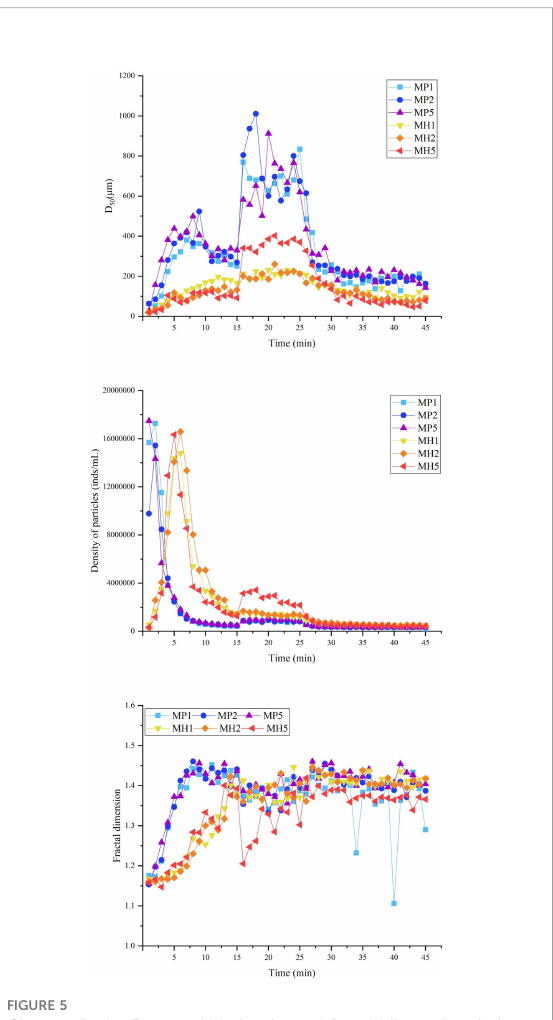
FIGURE 5 Changes in the D 50 , particle density and fractal dimension during fl occulation of microalgae with modi fi ed clay under coagulation